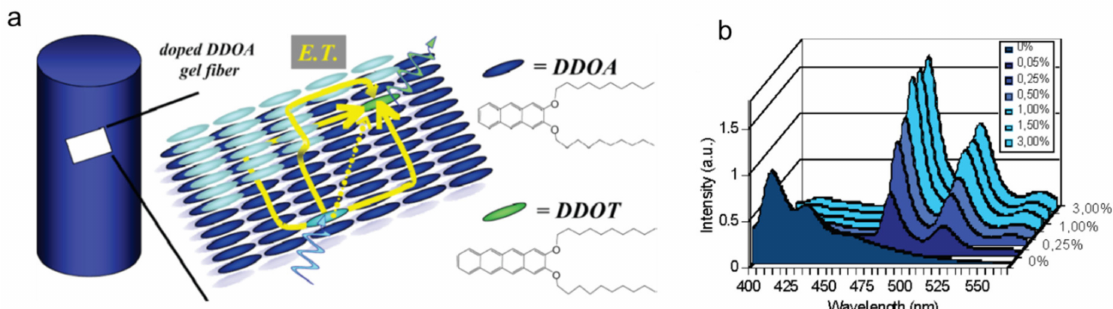
Figure 13. Molecular structures of DDOA, DDOT and DHDOT.